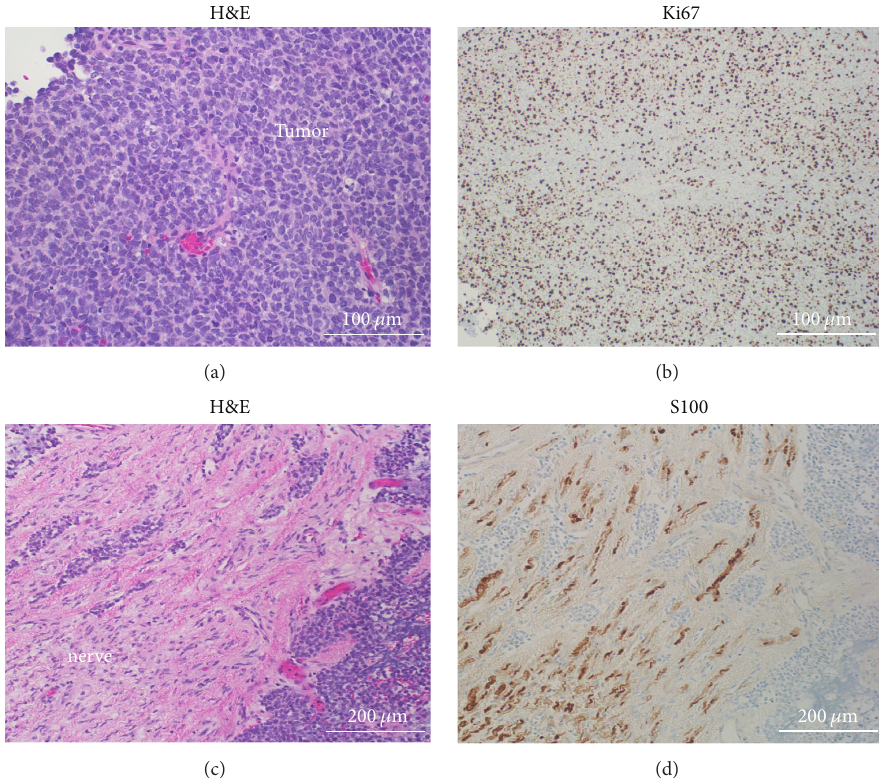
Figure 2: Histologic findings. (a) H&E stain within the tumor shows the small round blue cell appearance. (b) Ki67 immunostaining indicates a very high mitotic index (60–70%). (c) H&E stain demonstrates tumor invasion through the perineurium and into the right T11 nerve root. (d) Tumor invasion in the T11 nerve root is demonstrated by tumor cells interspersed within S100-positive Schwann cells. The tumor itself was S100-negative. H&E: hematoxylin &